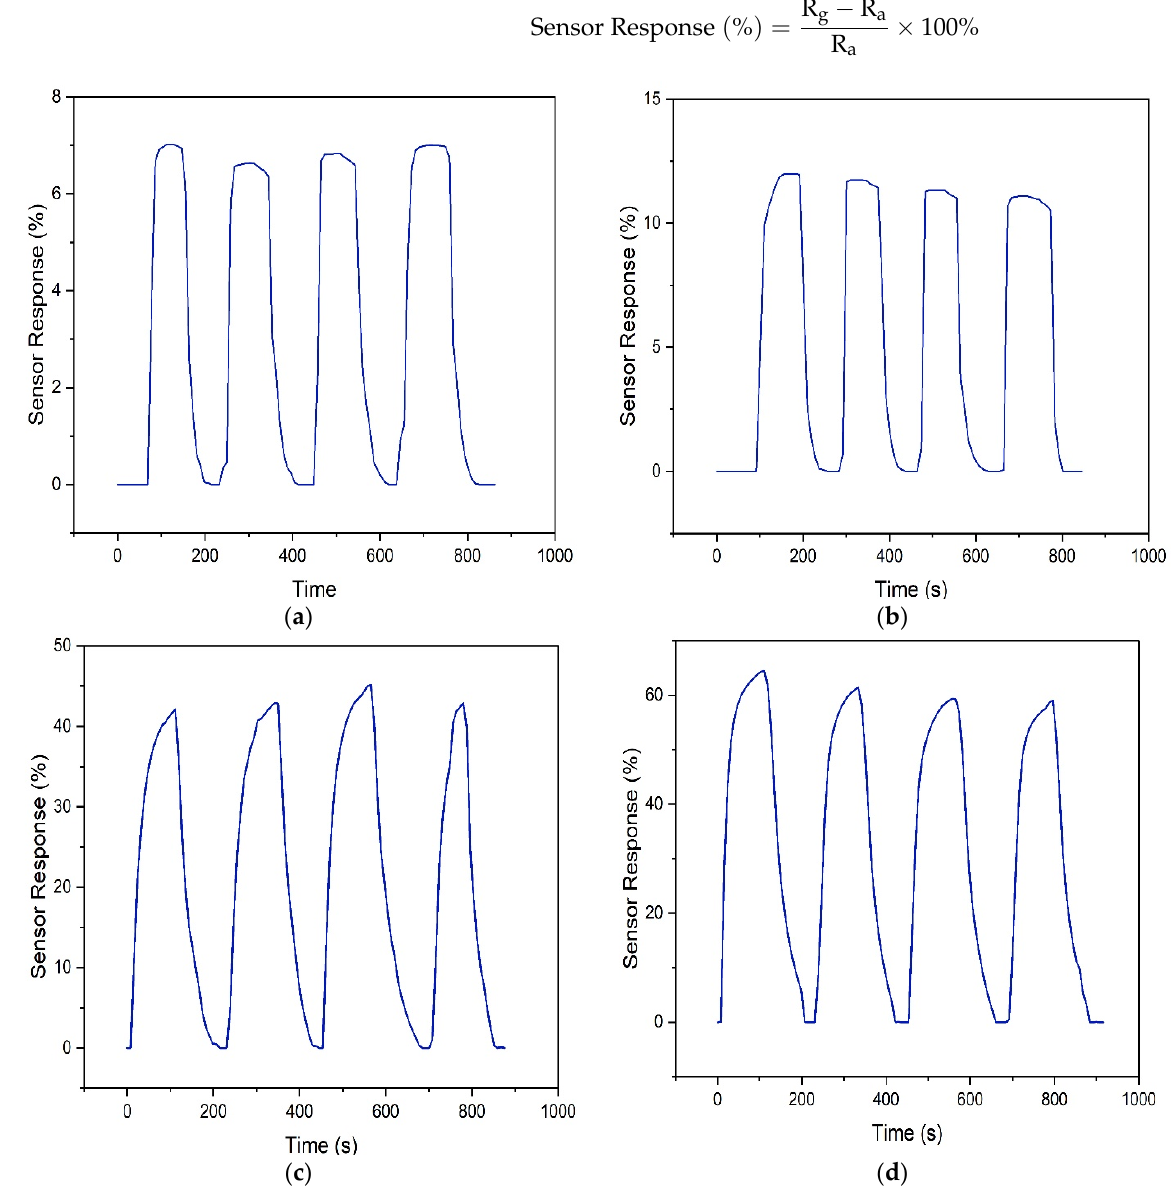
Figure 7. RGO and MOX sensor response (%) towards 100 ppm and 300 ppm ethanol. RGO ( a